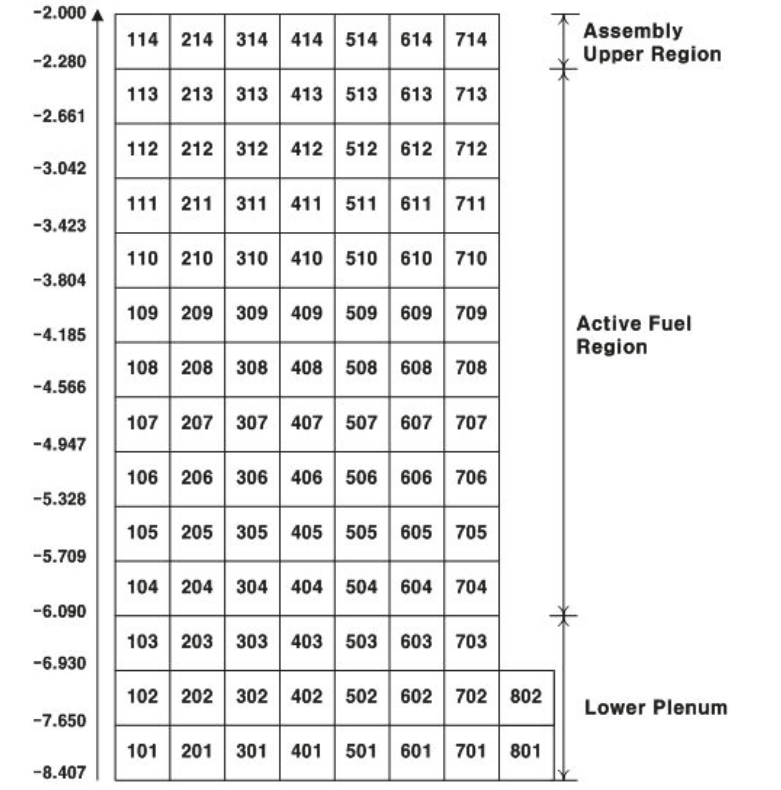
Figure 2: The core nodalization of OPR1000 MELCOR input model.